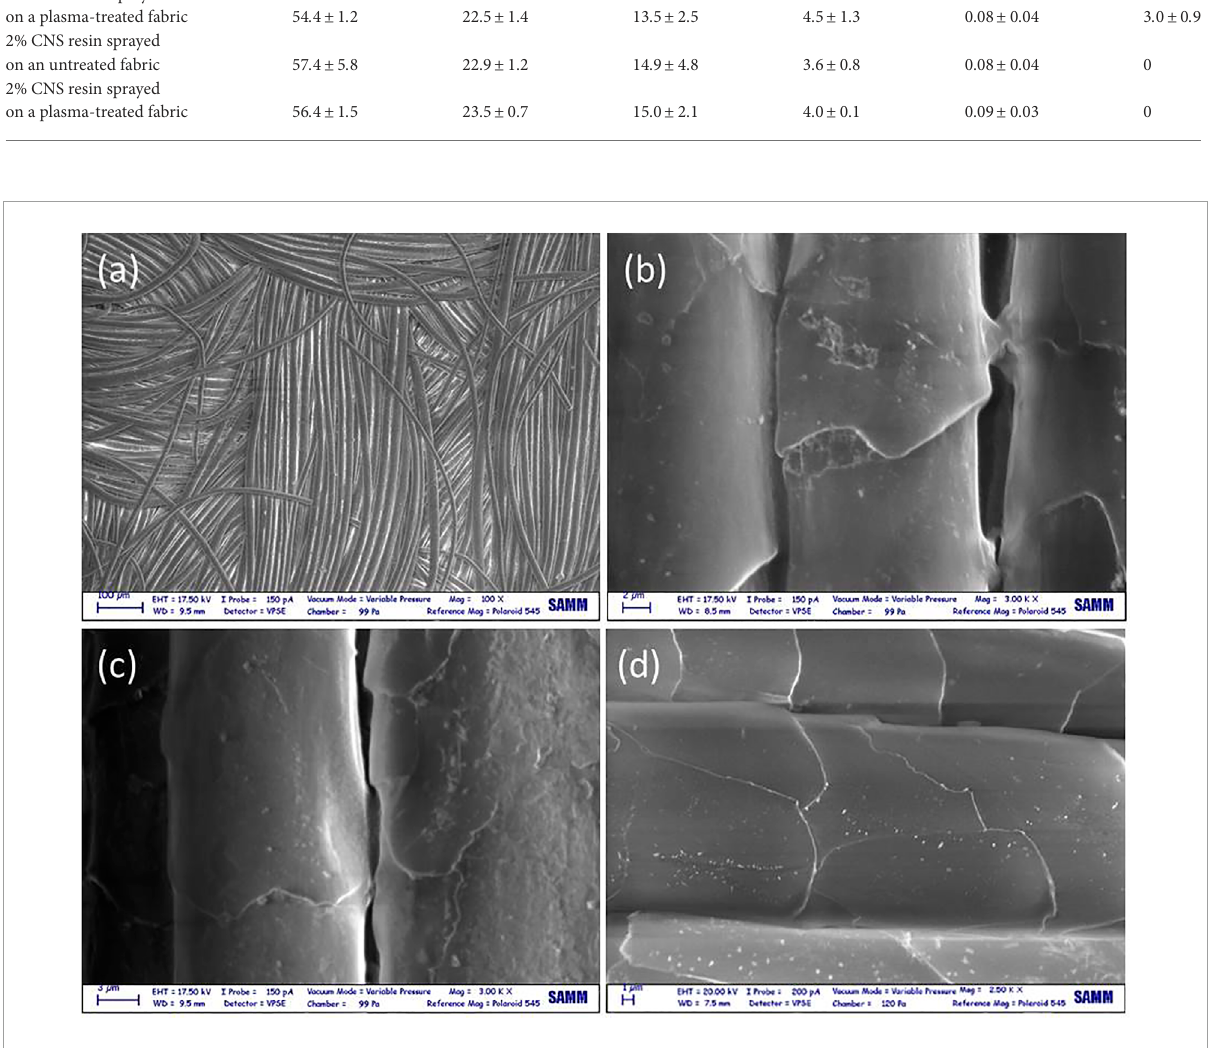
FIGURE 6 SEM image of (A) the plasma-treated and subsequently sprayed fabric at low magnification. SEM images at the highest magnification of (B) sprayed samples; (C) plasma-treated and subsequently sprayed samples; (D) plasma-treated-only